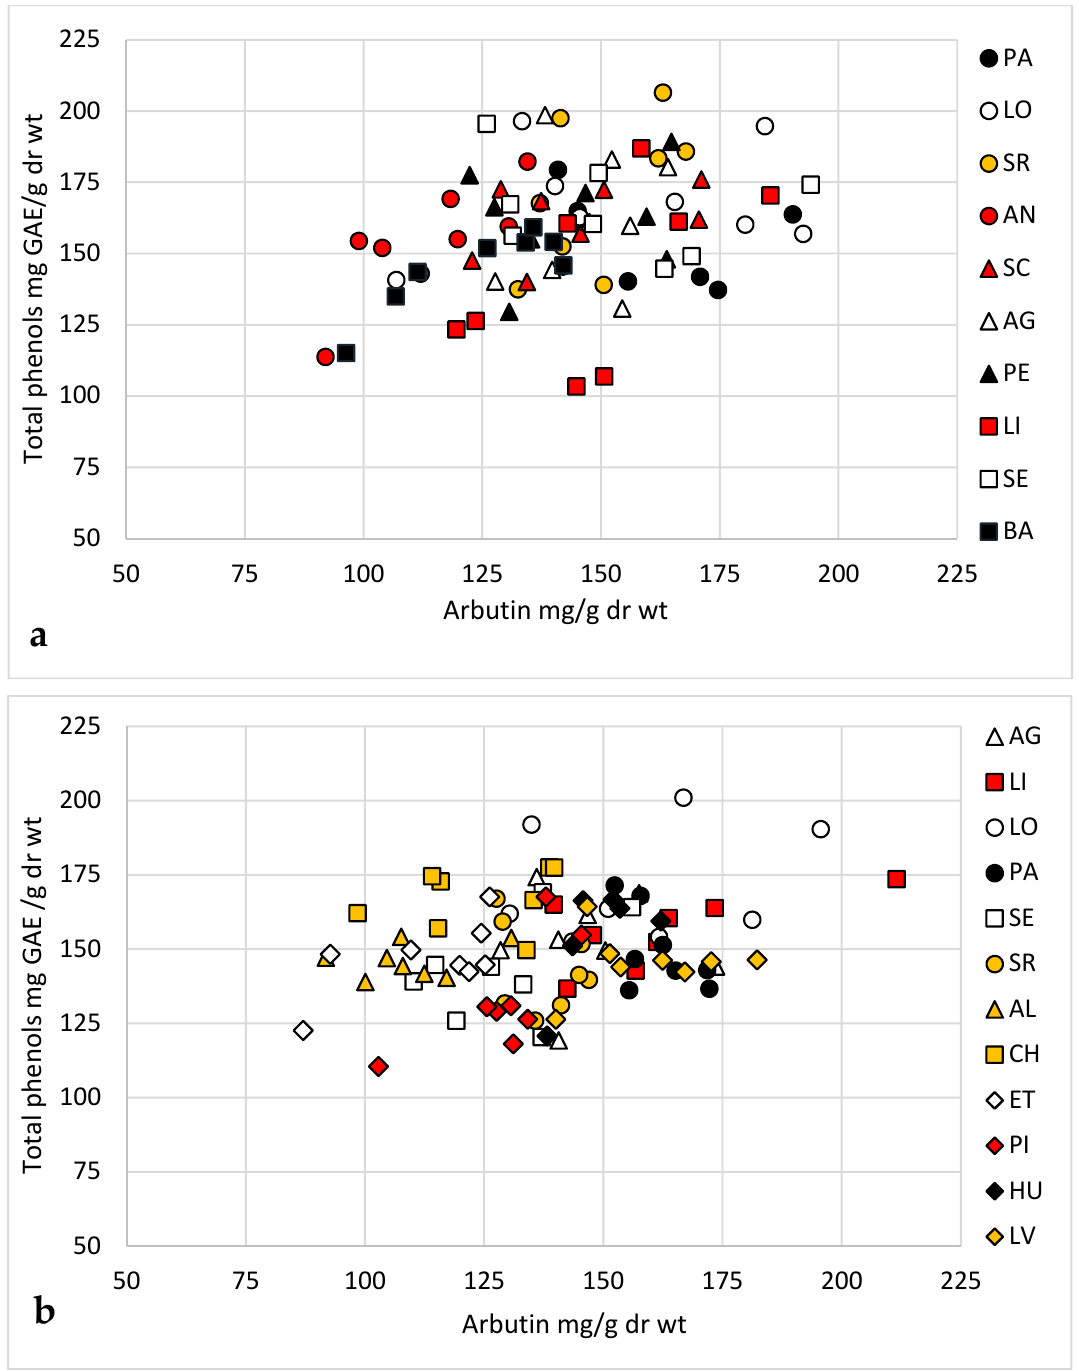
Figure 2. Total phenols (mg GAE/g dr wt) and arbutin (mg/g dr wt) content of leaves collected in 2014 from 80 bearberry plants growing in 10 natural populations of north Spain ( a ) and from 94 plants growing in 12 populations sampled in 2015 ( b ).